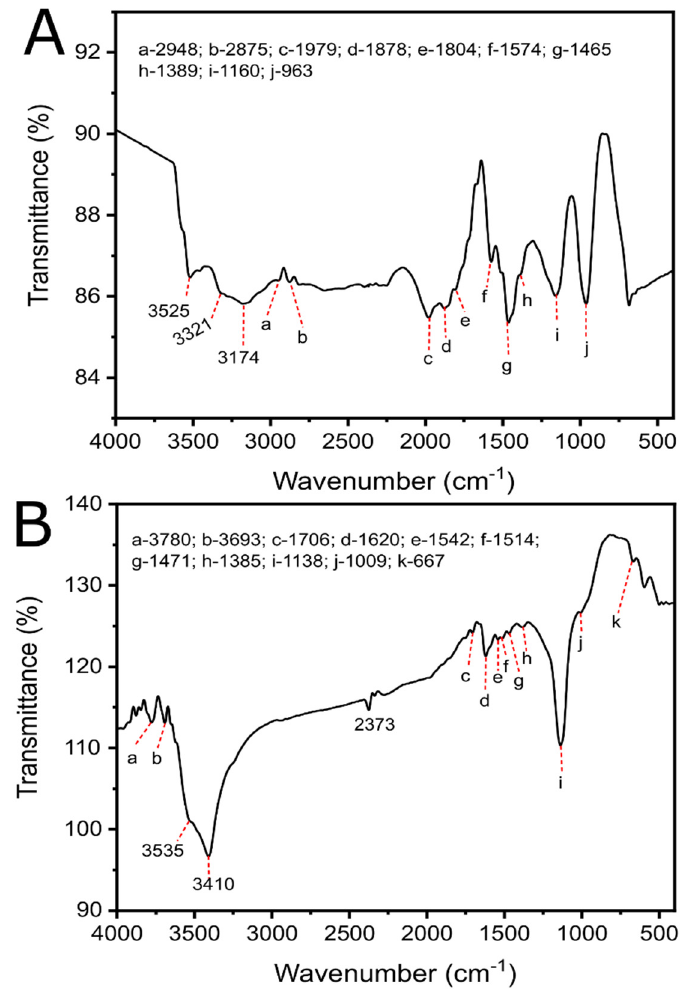
Figure 5. FTIR spectra of BBC samples ( A ) ZnCl 2 -BBC and ( B ) KOH-BBC.